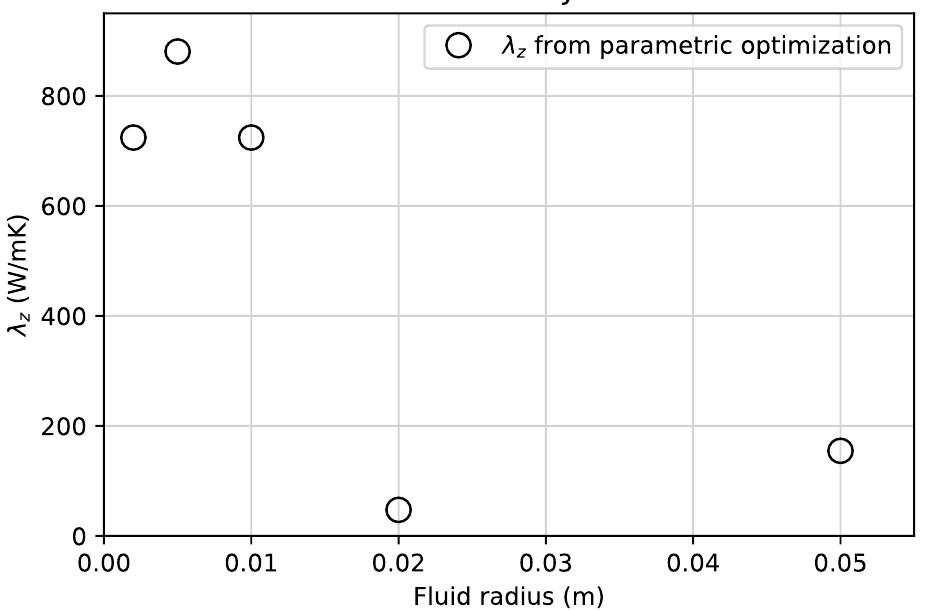
Figure 9. Resulting λ z from the optimization over the fluid radius r inner .